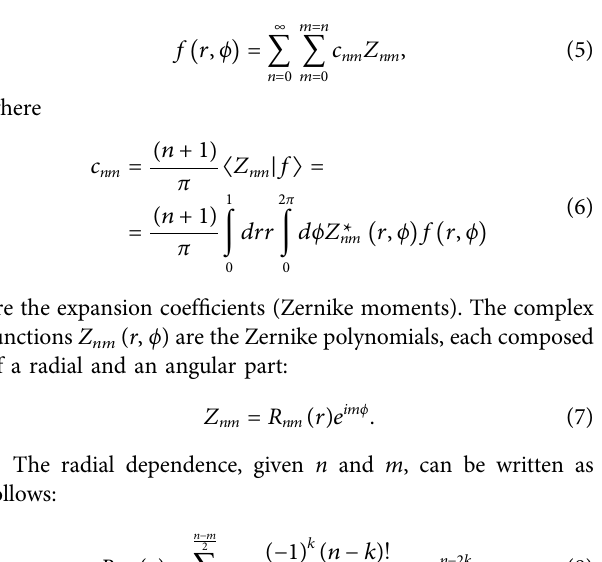
TABLE 1 | The residue substitutions performed during the shape optimization procedure.Thetemplatestructuresforthesialicacidbindingsite,spikeA,and spike B were 3bdy, 1yjd, and 1kb5, respectively. We adopted the Chotia numbering scheme. Epitope Chain ID Res no. Insert Original res Inserted